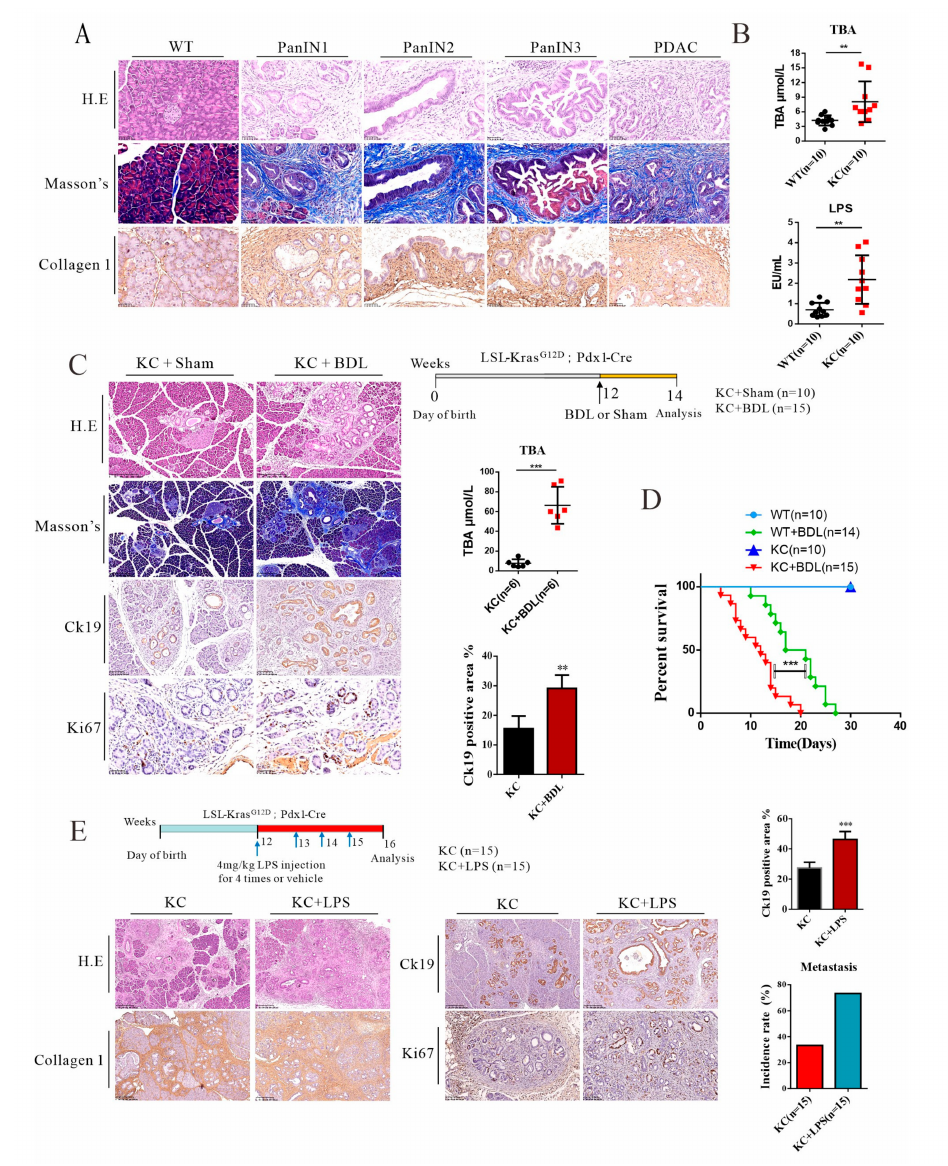
Figure 1. Elevated levels of systemic endotoxin and bile acids in Pdx-1-Kras mice are associated with metastatic progression in mice. ( A ) KC mice recapitulated the pathological characteristics of pancreatic cancer. Normal pancreatic tissue and different stages of pancreatic cancer—including PanIN1, PanIN2, PanIN3, and invasive PDAC—were illustrated by hematoxylin and eosin (H&E) staining and Masson’s trichrome staining, as well as immunohistochemical staining of type 1 collagen. Scale bars = 50 µ m. ( B ) Serum total bile acid and plasma endotoxin levels. ( C ) KC mice were subjected to bile duct ligation (BDL) or a sham procedure, as indicated by a scheme, KC + Sham ( n = 10) and KC + BDL ( n = 15) respectively. The pancreatic tissues were stained with H&E and Masson’s trichrome. Scale bars = 250 µ m. Representative images show pancreatic precursor lesions stained with Ck19 (scale bars = 100 µ m) and Ki67 (scale bars = 50 µ m) and quantitation of the percentage of CK19-positive duct-like structures. ( D ) Kaplan–Meier survival analysis of KC mice subjected to sham or BDL treatment. ( E ) A scheme depicts the protocol for KC mice that were given either a vehicle or LPS treatment. KC + vehicle ( n = 15) and KC + LPS ( n = 15). Pancreatic tissues were stained with H&E (scale bars = 250 µ m), type 1 collagen (scale bars = 250 µ m), Ck19 (scale bars = 250 µ m), and Ki67 (scale bars = 100 µ m). Quantitation of the percentage of CK19-positive area and metastasis incidence rate. Representative images of histological staining and IHC staining are shown. ** p < 0.01, *** p <